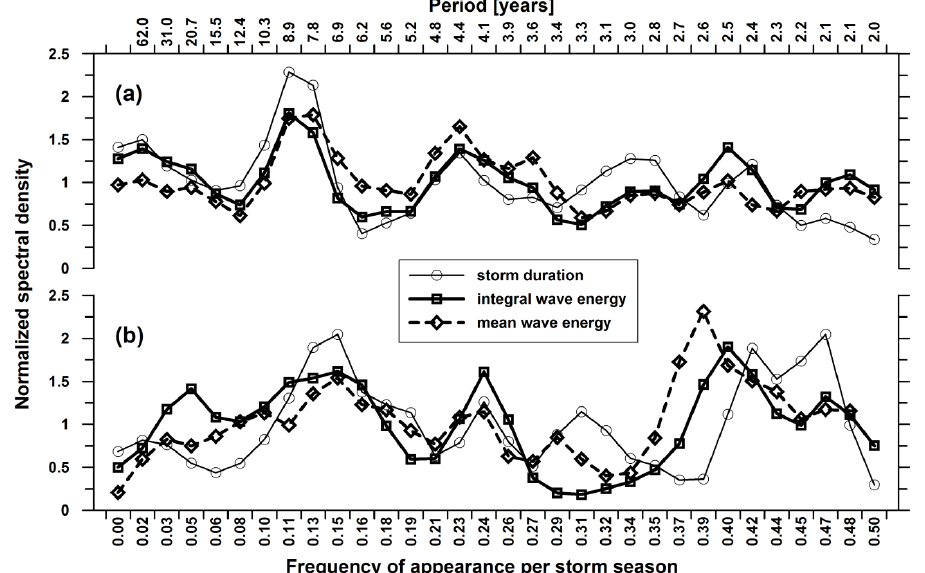
Figure 9. Normalized spectral density of total (a) and average (b) proxies 2 Fig. 9. Normalized spectral density of total (a) and average (b)